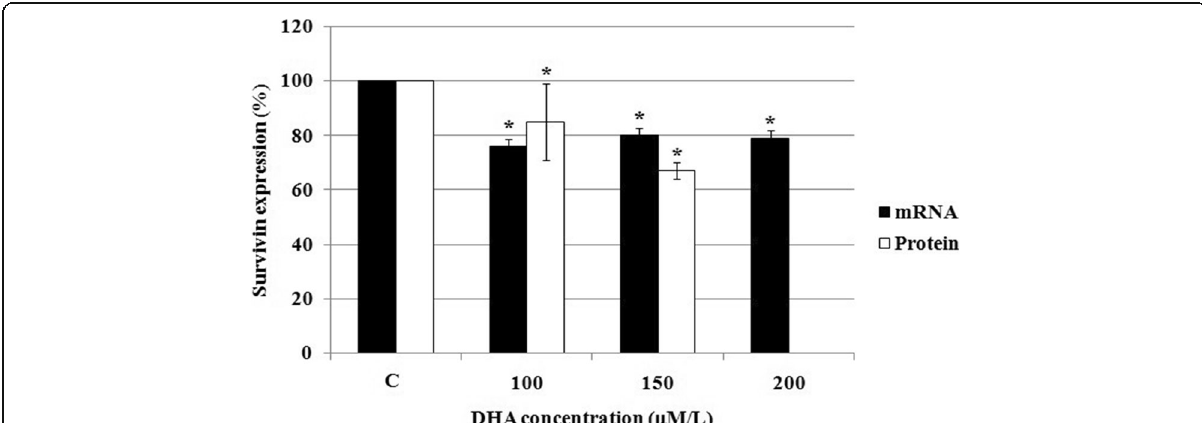
Fig. 3 Effect of DHA on the survivin expression. 5 × 10 5 HCT-116 cells per well were treated with different concentrations of DHA for 48 h, after which survivin mRNA and protein levels were determined by RT-PCR and sandwich ELISA methods, respectively. The data were expressed as %